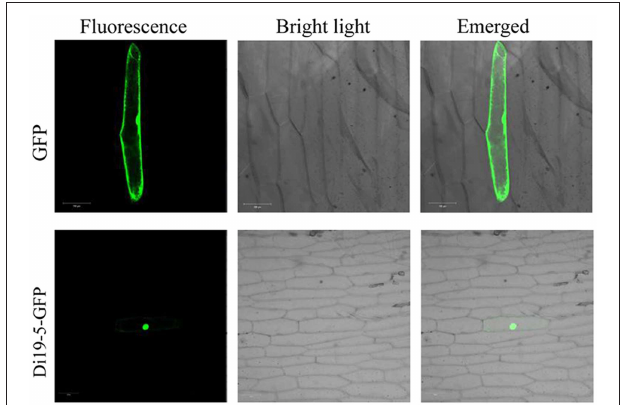
FIGURE 7 | Subcellular localization of GmDi19-5 protein. GFP and GmDi19-5-GFP represented subcellular localization of the control 16318GFP and GmDi19-5 in onion epidermal cells, respectively.